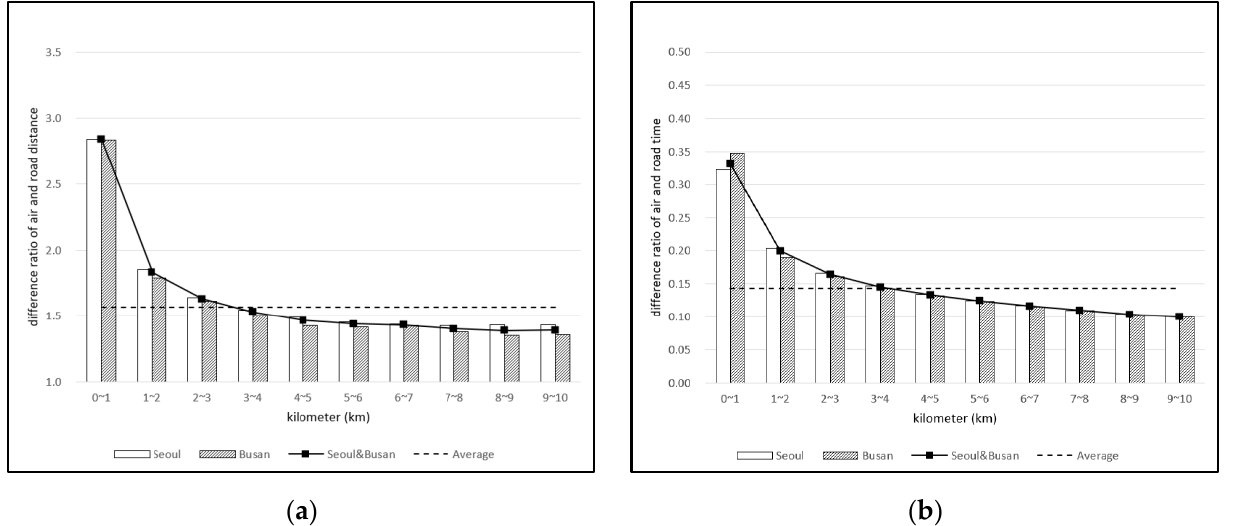
Figure 11. General conversion ratio for air distance: ( a ) to road distance; ( b ) to road time.